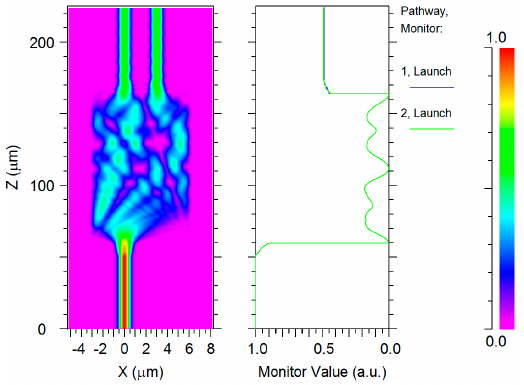
Figure 5. The propagation of the optical field in the MMI coupler with the designed parameters.